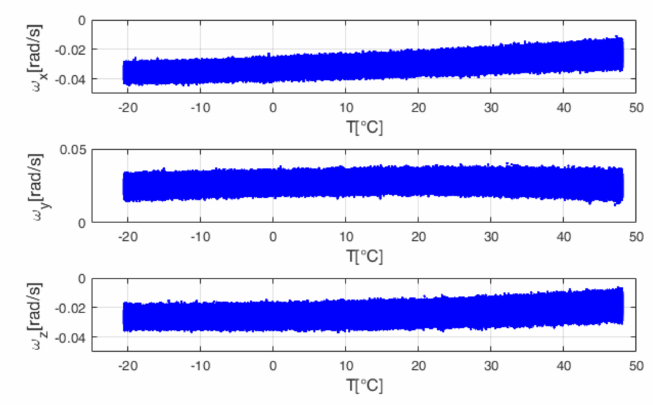
Figure 5. Gyro output ( ω x , ω y , ω z ) vs. temperature for the soak test.